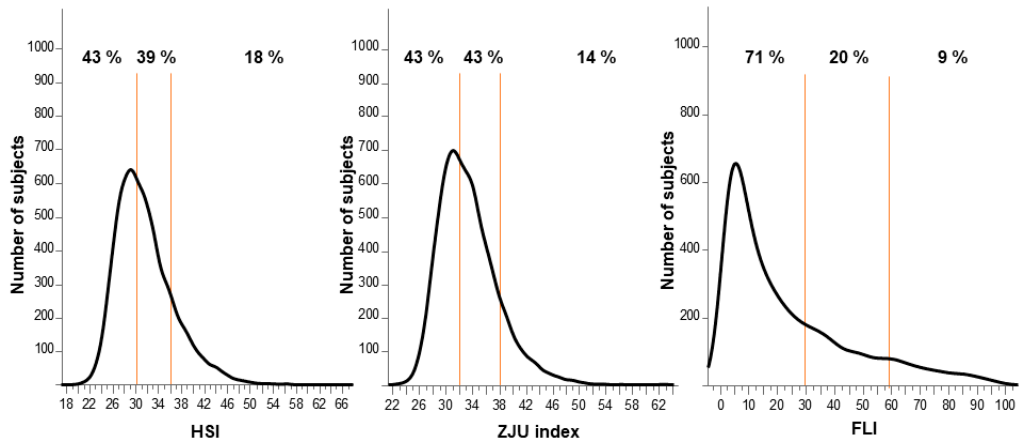
Figure 1. Frequency distribution of the HSI, ZJU index, and FLI. Graphs represent the frequency distribution of the HSI, ZJU index, and FLI. Orange lines represent cut-off values: 30 and 36 for the HSI, 32 and 38 for the ZJU index, and 30 and 60 for the FLI. The percentages in the graphs represent the proportion of subjects in each range. FLI, fatty liver index; HSI, hepatic steatosis index; ZJU, Zhejiang University.